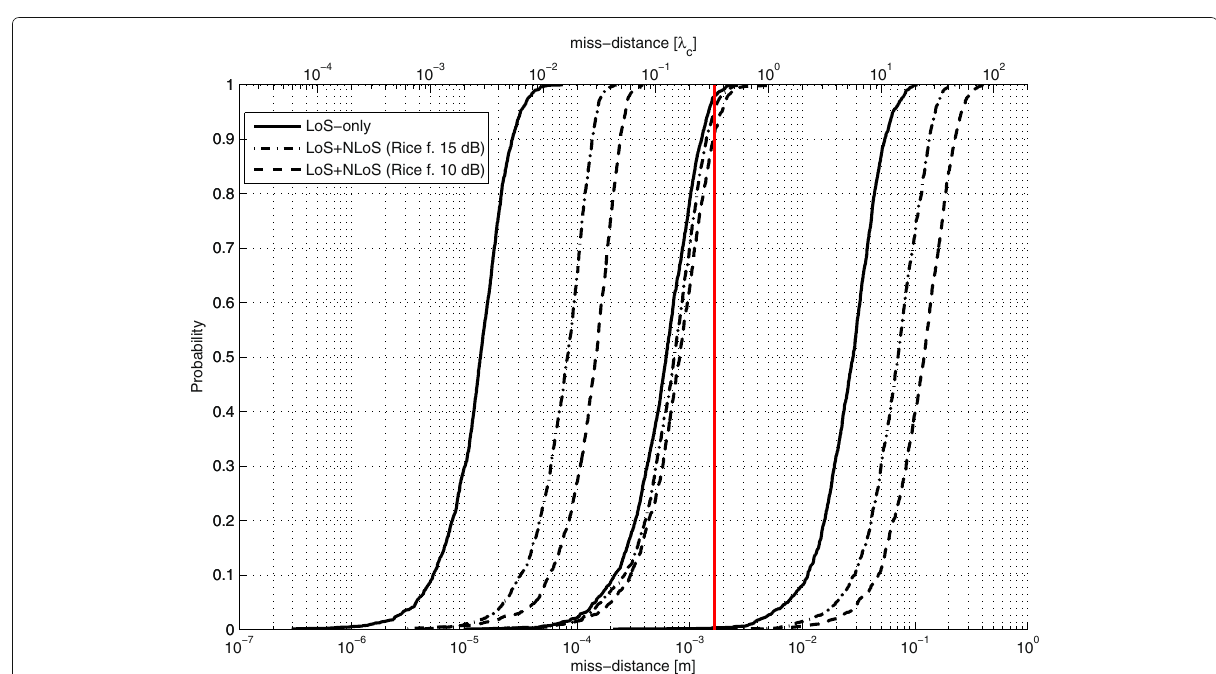
Fig. 21 CDF curves of localization errors for different stages and Rice factors for SNR 0 = 10 dB stage, we show a CDF curve for LoS-only and Rice factor values of 15 and 10 dB. Geometry G 2 was used (in stage 2). Again, these results hold for outcomes when the main lobe in stage 3 is not missed. In stage 1, compared to the LoS-only curve, the error is increased roughly 2.5 and 4.3